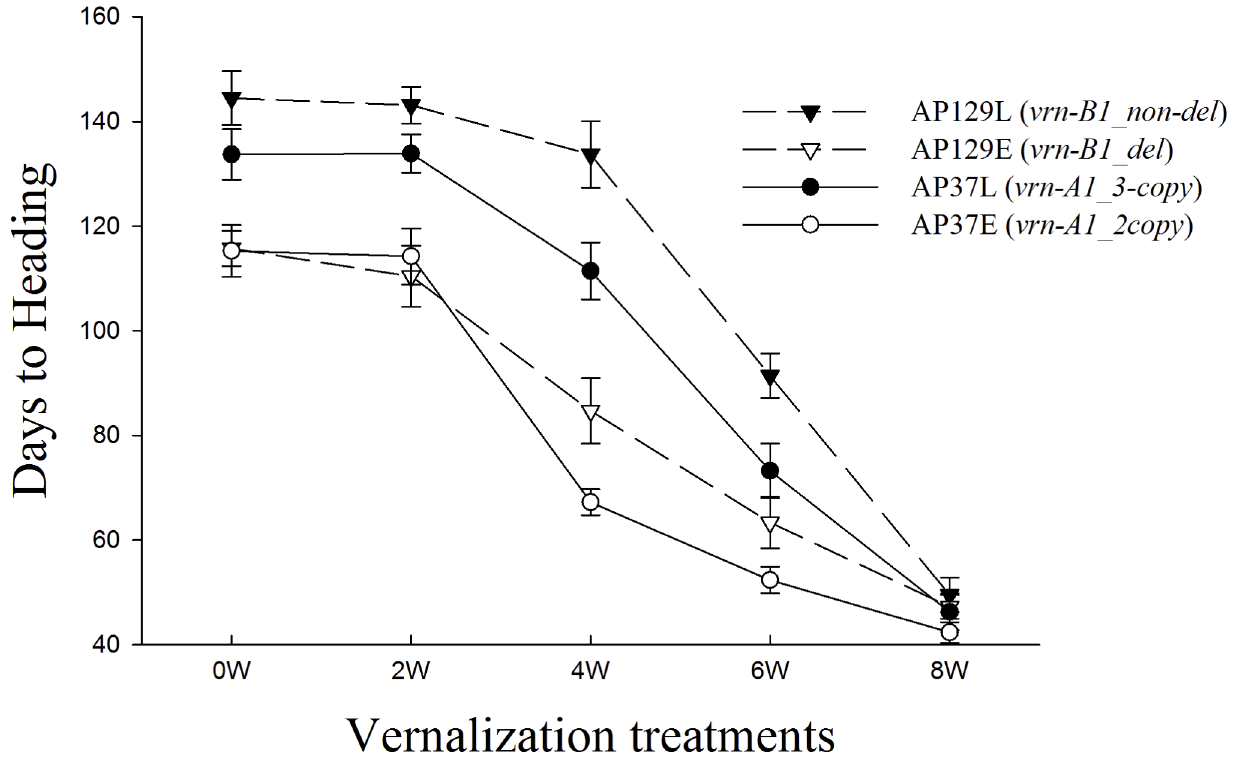
Fig 4. Effect of vernalization treatment on days to heading of near isogenic lines (NILs). NILs originate from recombinant inbred lines AP129 and AP37. NILs AP129 have PPD-A1a , PPD-B1a , PPD-D1a , vrn-A1_3-copy and differ for VRN-B1 alleles. AP129L has the vrn- B1_non-del allele while AP129E has the vrn-B1_del allele. AP37E and AP37L have PPD-A1a , PPD-B1b , PPD-D1a , vrn-B1_non-del and differ for VRN-A1 alleles. AP37E has vrn-A1_2-copy while 37L has vrn-A1_3-copy .